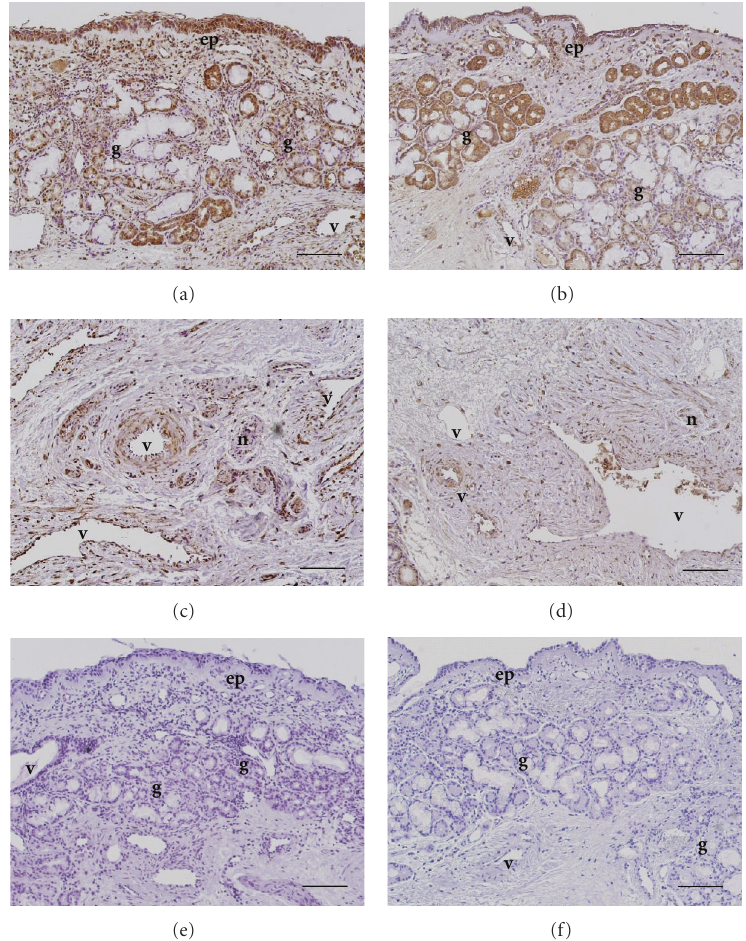
Figure 1: Immunohistochemical staining for bradykinin B1 receptor in human allergic (a), (c), (e) and nonallergic (b), (d), (f) nasal mucosa. Inferior turbinates were stained with antihuman B1 receptor antibody (a)–(d) or normal rabbit immunoglobulin (e), (f). Immunoreactivity for B1 receptor was significantly detected in submucosal glands (a), (b), epithelial cells (a), (b), and fibroblasts (c), (d). ep: epithelial cells; v: blood vessels; g: submucosal glands; n: nerves. Scale bar = 100 μ